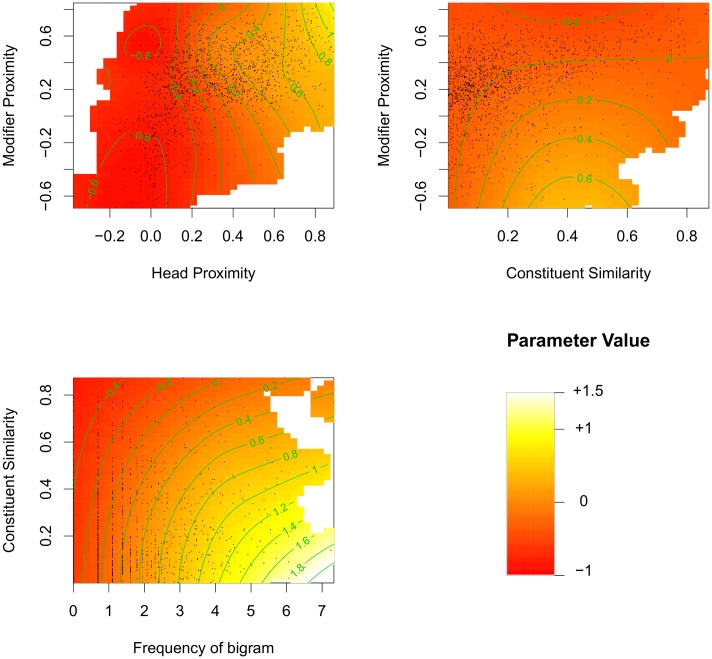
Heat maps for the non-linear interaction effects including plausibility measures.The colours indicate parameter values (i.e., predicted deviation from the mean), the points show the data points from which the model was estimated. Upper left: Interaction between Head and Modifier Proximity. Upper right: Interaction between Modifier Proximity and Constituent Similarity. Lower left: Interaction between frequency of bigrams and Constituent Similarity. Lower right: Legend.